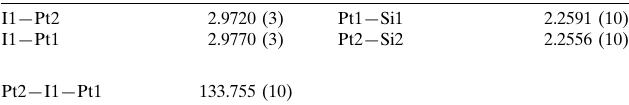
Selected geometric parameters (A˚ , (cid:3)